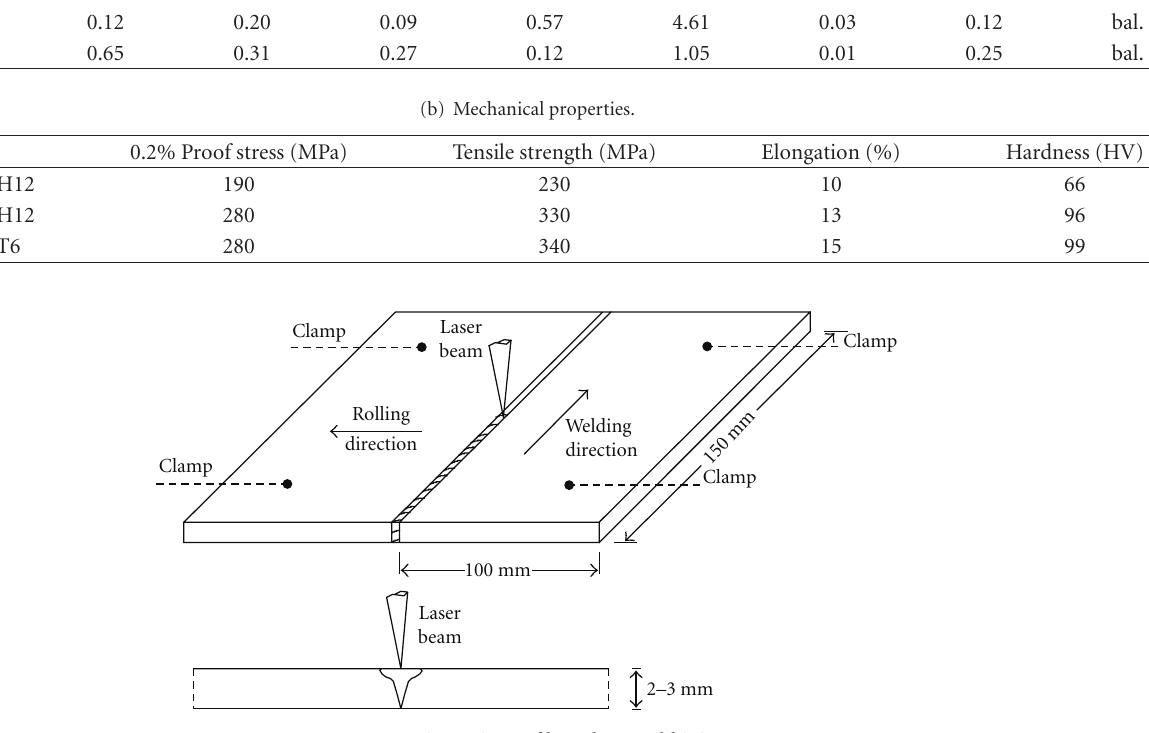
Figure 1: Dimensions of laser butt weld joints.